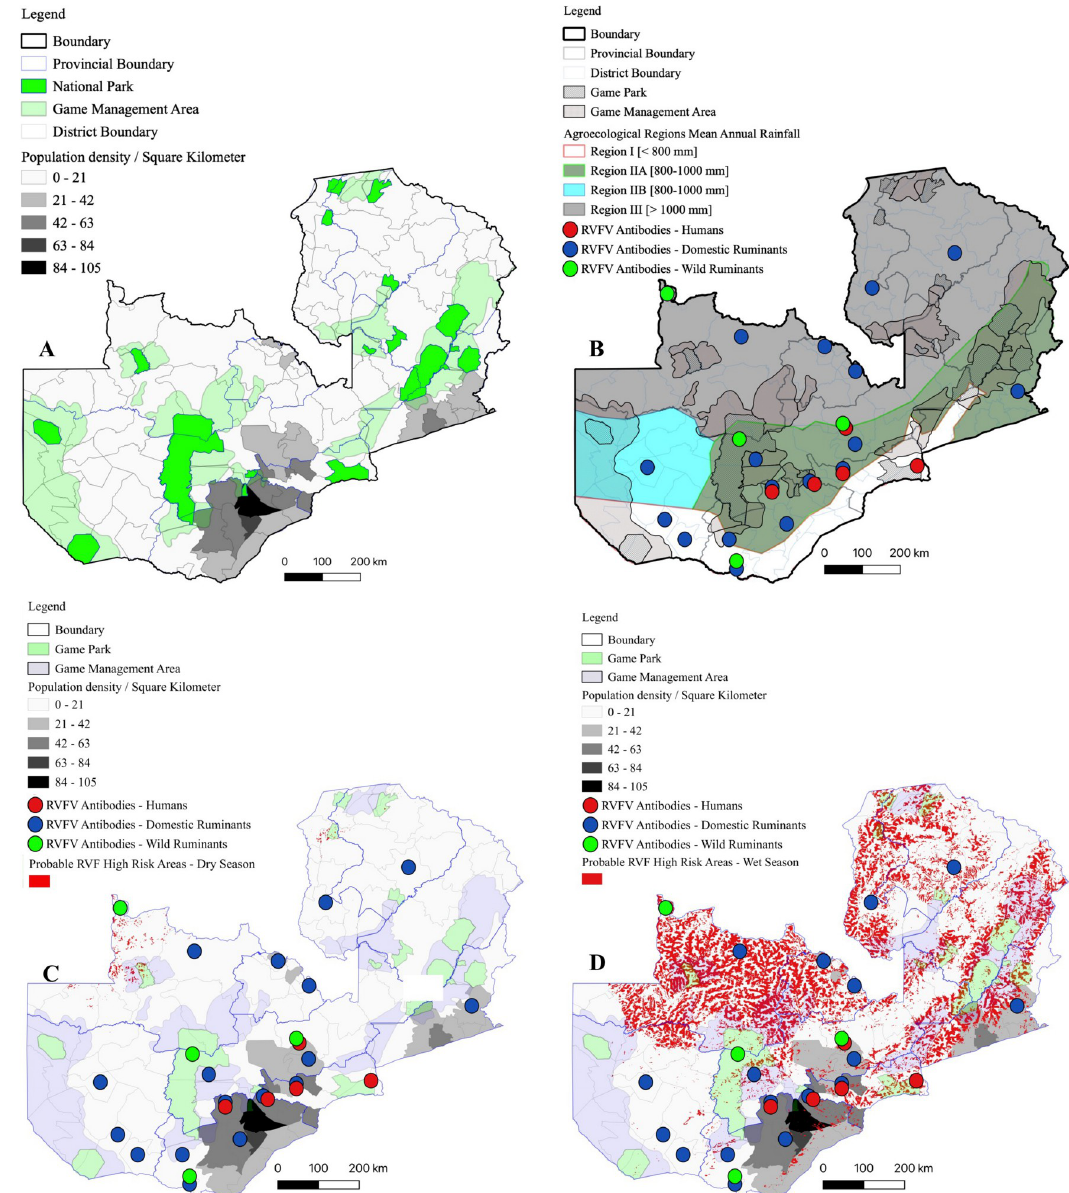
Fig 7. Ruminant population density and RVF risk map. (A) Domestic ruminant population density map. (B) Location of RVF outbreaks, past and present seropositive results. (C & D) RVF high risk areas in at the onset (November) and end of the rain season (March). Shapefile republished from DIVA-GIS database (https://www.diva-gis.org/) under a CC BY license of Global Administrative Areas (GADM), copyright